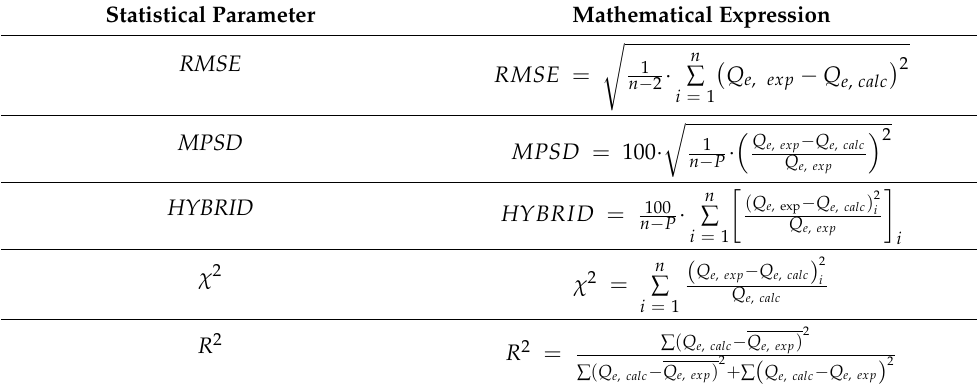
Table 3. Equations used for statistical error